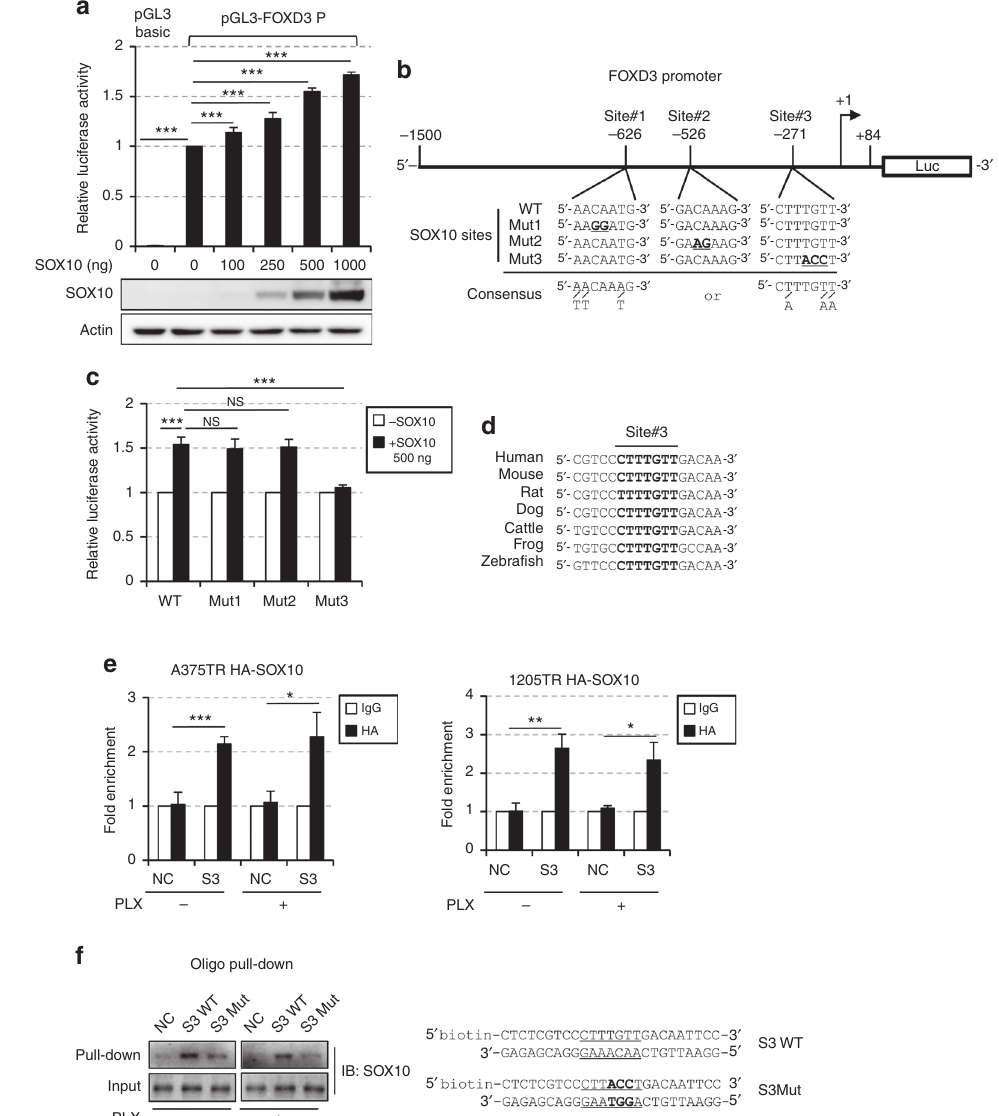
Fig. 2 SOX10 activates the transcription of FOXD3 by direct binding to FOXD3 promoter. a HEK293T cells were co-transfected with 500 ng pGL3-FOXD3 (or pGL3-Basic as negative control), 50 ng pRL-TK and an increasing amount of pLentipuro/TO/HA-SOX10 plasmids. After 48 h, cells were lysed and dual- luc fi ferase assays were performed. Average relative luciferase activities from three experiments are shown. The expression of SOX10 was veri fi ed by western blot. Error bars represent standard deviation. Signi fi cance was determined by ANOVA one-way test, *** p < 0.001. b A schematic illustration of FOXD3 promoter region. The positions and sequences of three putative SOX10 binding sites were highlighted. The +1 arrow designated the transcription initiation site. The mutated SOX10 binding sites and the consensus motif are shown. Mutated nucleotides were underlined. c HEK293T cells were co- transfected with 500 ng pGL3-FOXD3 promoter constructs carrying either WT sequence or mutations in either of the three putative SOX10 binding sites, 50 ng pRL-TK and 500 ng pLentipuro/TO/HA-SOX10 for 48 h. Cells were then lysed for dual-luciferase assay. Average relative luciferase activities from three experiments are shown. Error bars represent standard deviation. Signi fi cance was determined by ANOVA one-way test, *** p < 0.001. d Sequence alignment of SOX10 binding site #3 in FOXD3 promoters from different species. The SOX10 binding sites were in bold. e A375-TR HA-SOX10 and 1205Lu- TR HA-SOX10 cells were treated with 2 μ M Vemurafenib for 6 h. Occupancy of SOX10 (HA) on a region surrounding site #3 in FOXD3 promoter and a region between the GAPDH and CNAP1 genes (negative control) was evaluated by ChIP analysis. Average results from three independent experiments are shown. Error bars represent standard deviation. Signi fi cance was determined by ANOVA one-way test, * p < 0.05; ** p < 0.01; *** p < 0.001. f Oligo pull- down assays were performed using nuclear extracts from A375 cells treated with or without 2 μ M Vemurafenib for 6 h and biotin-labeled FOXD3 promoter fragments containing WT or mutated SOX10 binding site #3. Non-biotinylated DNA fragments (NC) were used as a negative control. The nucleotide sequences of promoter fragments are shown on the right. SOX10 binding sites were underlined and mutated nucleotides were highlighted in bold. Uncropped images are shown in Supplementary Fig.